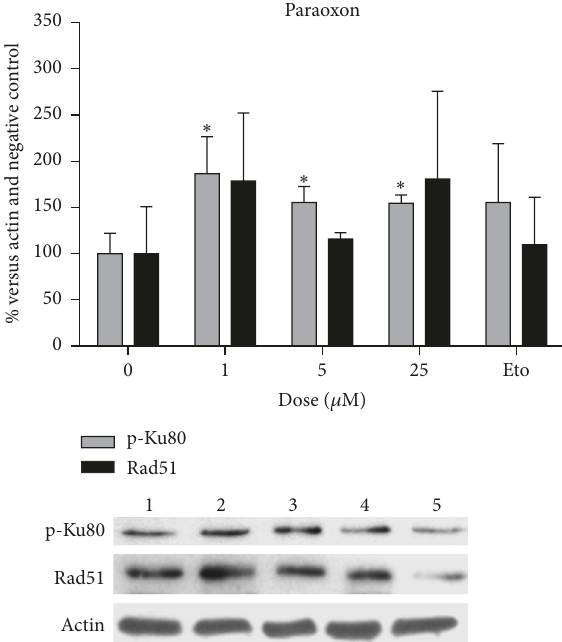
Figure 2: Increase in the amount of p-Ku80 protein in cells treated with paraoxon: lane 1, negative control; lanes 2–4, paraoxon (1, 5, and 25 microM); lane 5, etoposide (10 microM). Rad51 did not show significant variation among treatments as is shown in the graph. ∗ Significantly different dose; Kruskal-Wallis; Dunn’s post hoc test, 𝑝 < 0.05 .